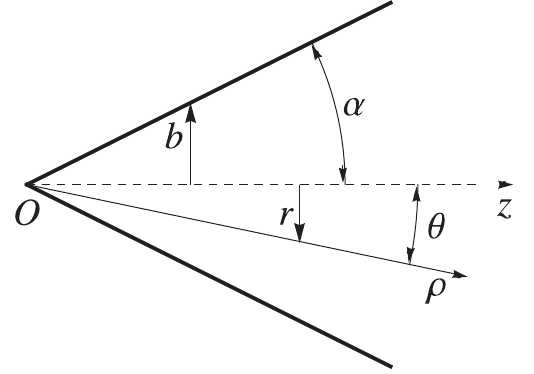
(A5) FIG. 5. Spherical and cylindrical coordinate systems